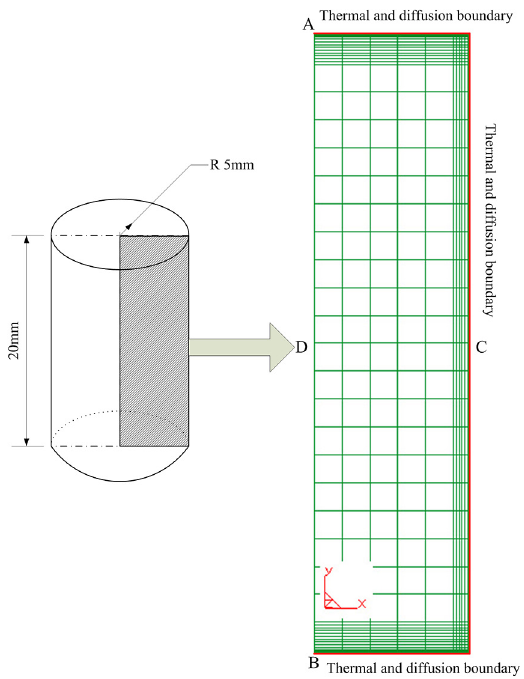
Figure 2. FEM model and